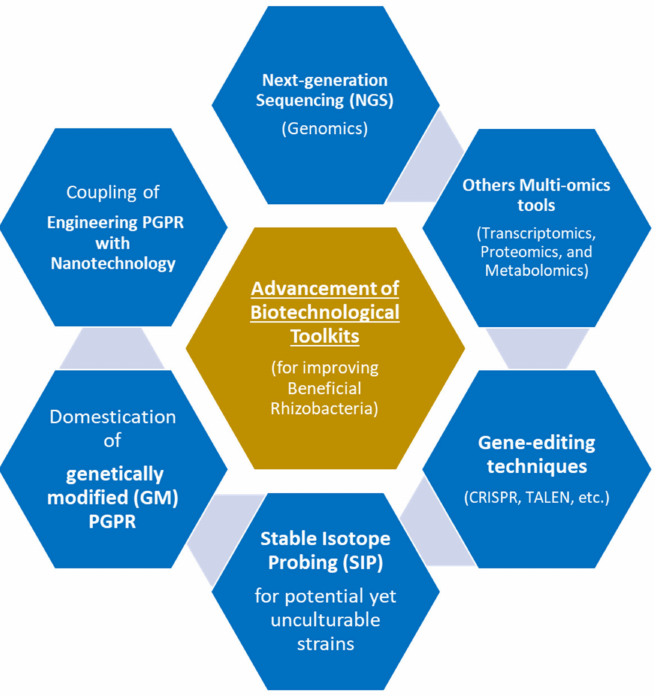
Figure 4. Advancement of biotechnological approaches for a sustainable enhancement of beneficial